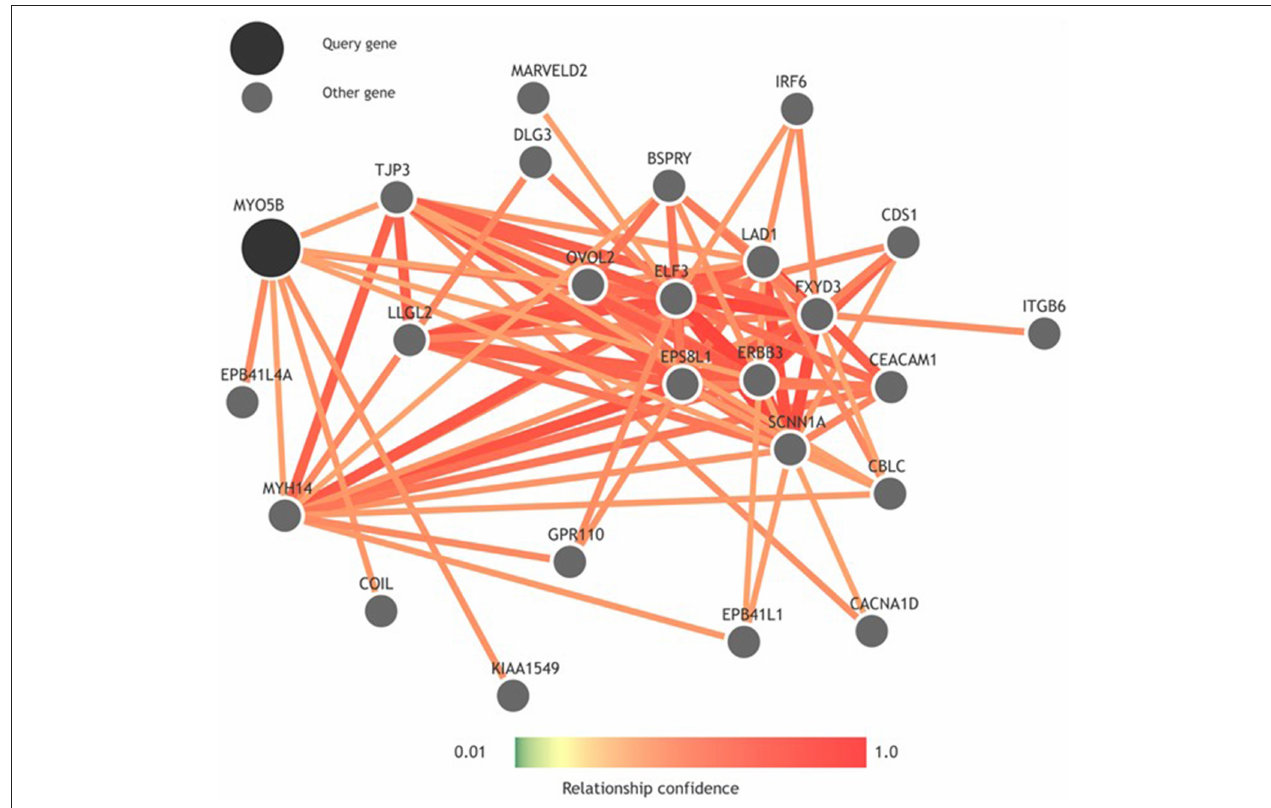
FIGURE 2 | Functional network built using GIANT (Genome-scale Integrated Analysis of gene Networks in Tissues) showing neighbors of